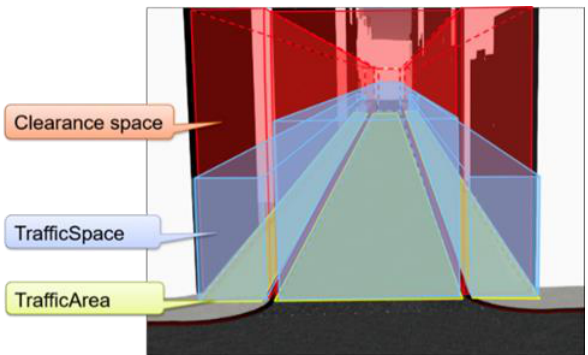
Figure 5. Space concept for Transportation objects in CityGML 3.0 [5].